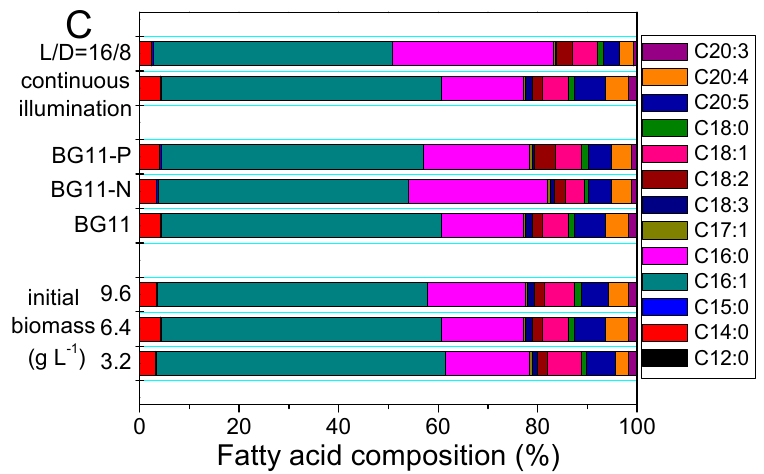
Figure 4. Growth curve ( A ), cellular components ( B ) and fatty acid profiles ( C ) of T. minus under the photoautotrophic regime. Values shown are averages of three replicates and error bars represent the standard deviations for the replicates.